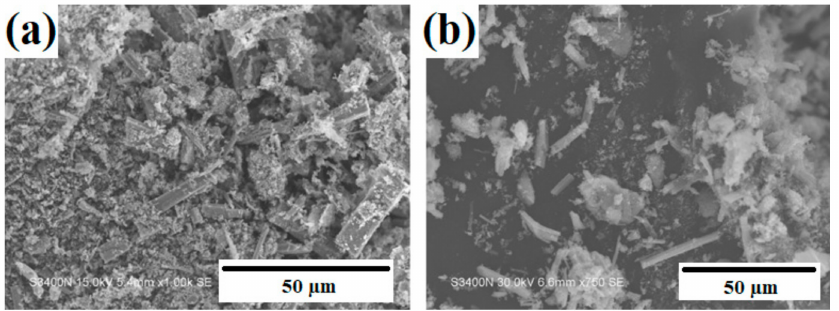
Figure 3. SEM images of a TiO 2 -ZnO oxide system subjected to calcination at temperatures of ( a ) 500 ◦ C and ( b ) 600 ◦ C (created based on [65] with permission from Elsevier